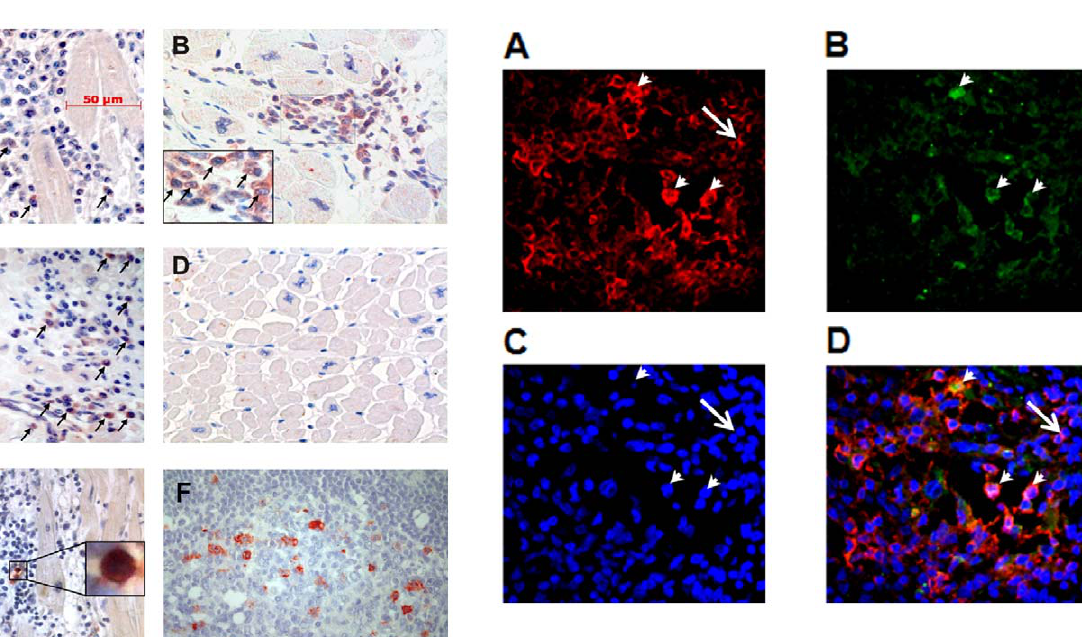
Figure 8. CTLA-4 is expressed by infiltrating T lymphocytes in the heart of chronic Chagas disease patients. Double immuno- fluorescence staining with CD3 and CTLA-4 antibodies was performed as described in Material and Methods. From total CD3-expressing T cells present in the inflammatory infiltrate (A) a small proportion showed CTLA-4 expression (B). Nuclei staining with DAPI. The arrowheads point the nuclei of CTLA4 + cells (C). Composite of figures A, B and C showing the double stained cells (arrowheads) and a CD3 + CTLA-4 2 single stained cell (large arrow)(D). Original Magnification 400 6 .